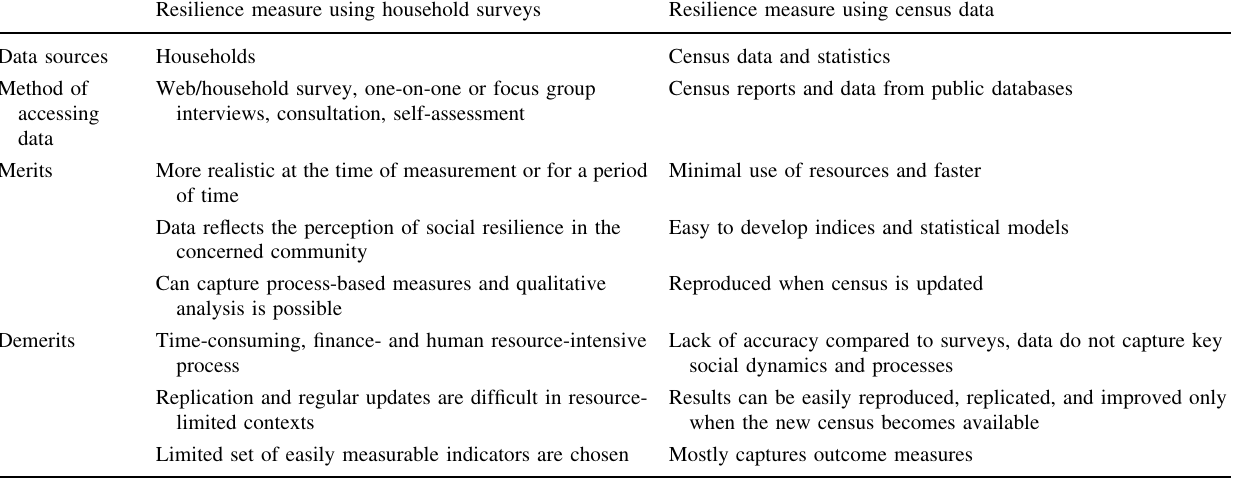
Table 1 Comparison of methods to assess social resilience Resilience measure using household